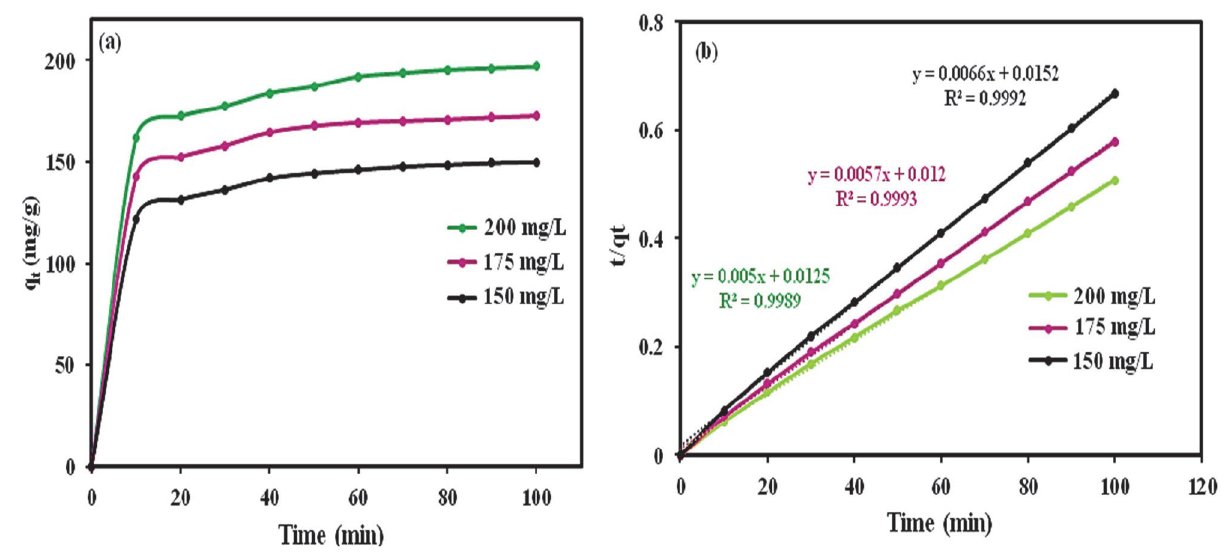
Figure 12. Kinetic adsorption data plots for MB: (a) plot of removal rate qt vs. t and (b) pseudo-second- order adsorption kinetics on